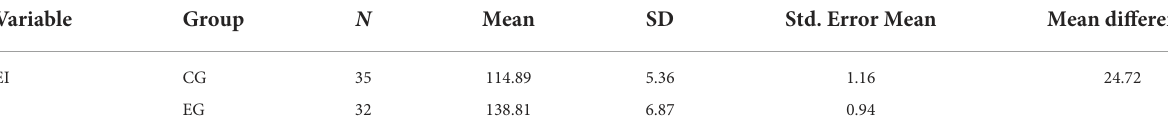
TABLE 2 Descriptive statistics of EI posttest scores.